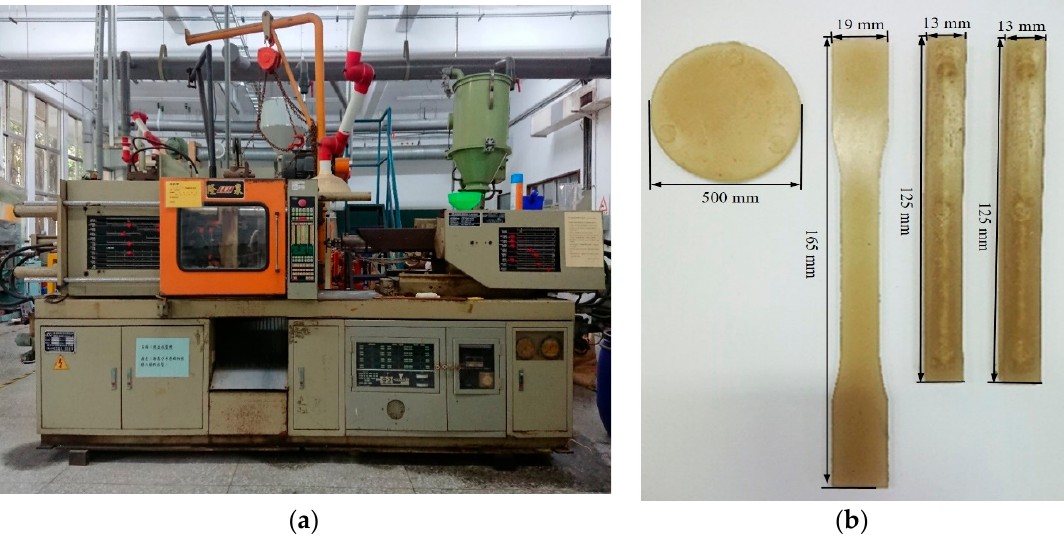
Figure 9. Plastic injection molding machine: ( a ) Plastic injection molding machine. ( b ) Injection molding samples.